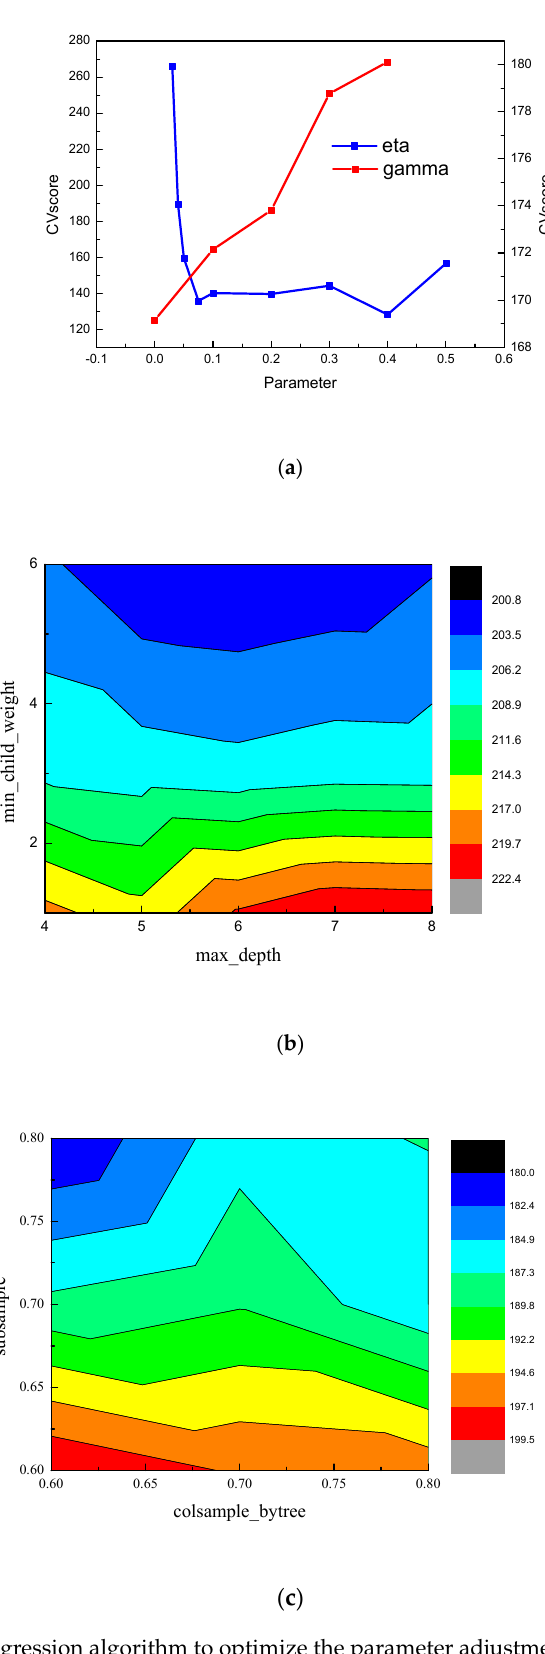
Figure 7. XGBOOST regression algorithm to optimize the parameter adjustment process: ( a ) eta and gamma parameter optimization; ( b ) max_depth and min_child_weight parameter optimization; ( c ) colsample_bytree and subsample parameter optimization.